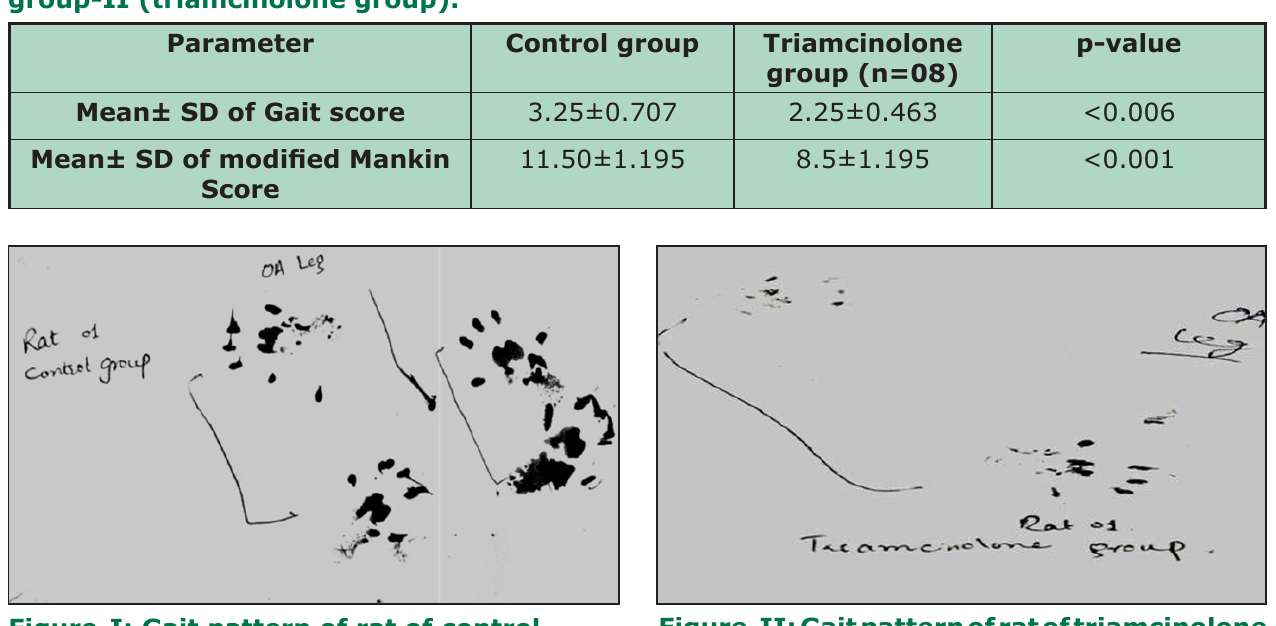
Figure-I: Gait pattern of rat of control group.